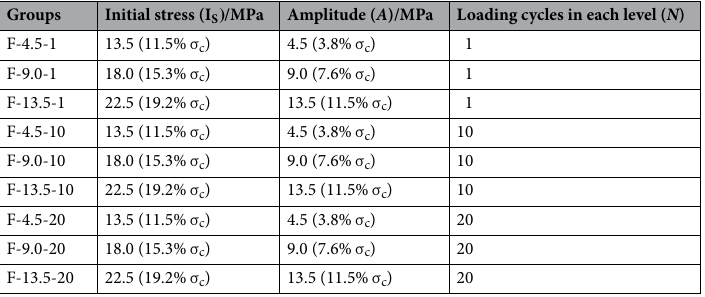
Table 2. The testing schemes for multi-level cyclic loading.